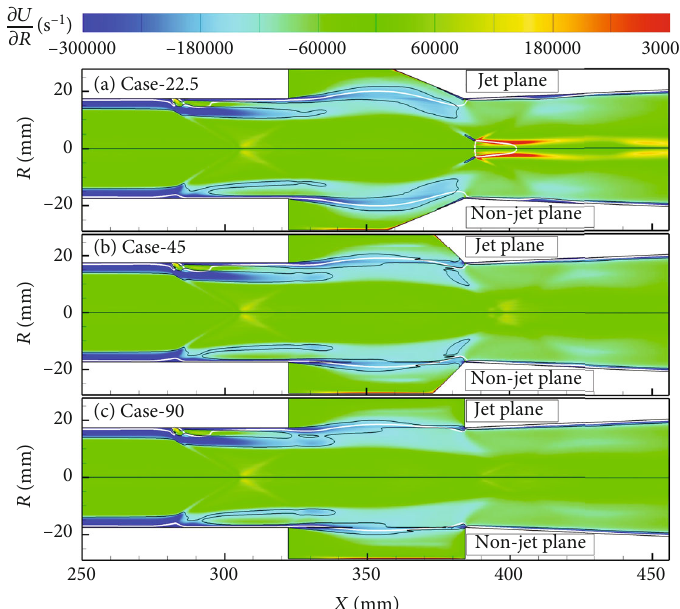
Figure 8: Contours of streamwise velocity partial derivative in the radial direction of all cases in the nonreacting fl ow fi eld; the white solid line is the isoline of sonic speed; the boundary of the cavity shear layer is marked by a black solid line where ∂ U / ∂ R = − 15000s − 1